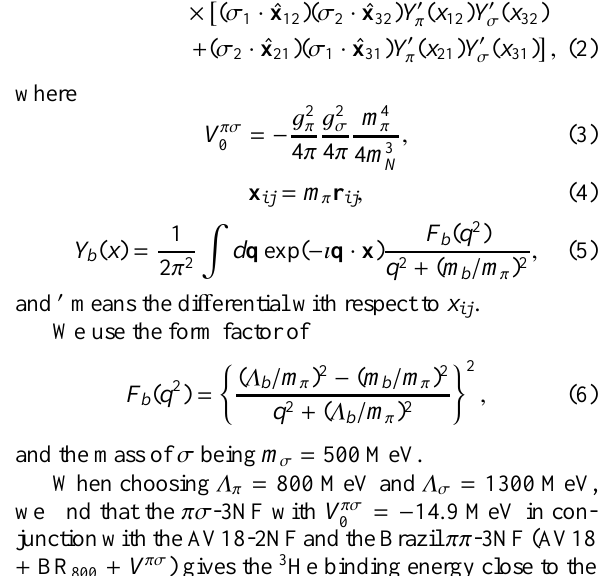
= 19.0 MeV. The solid